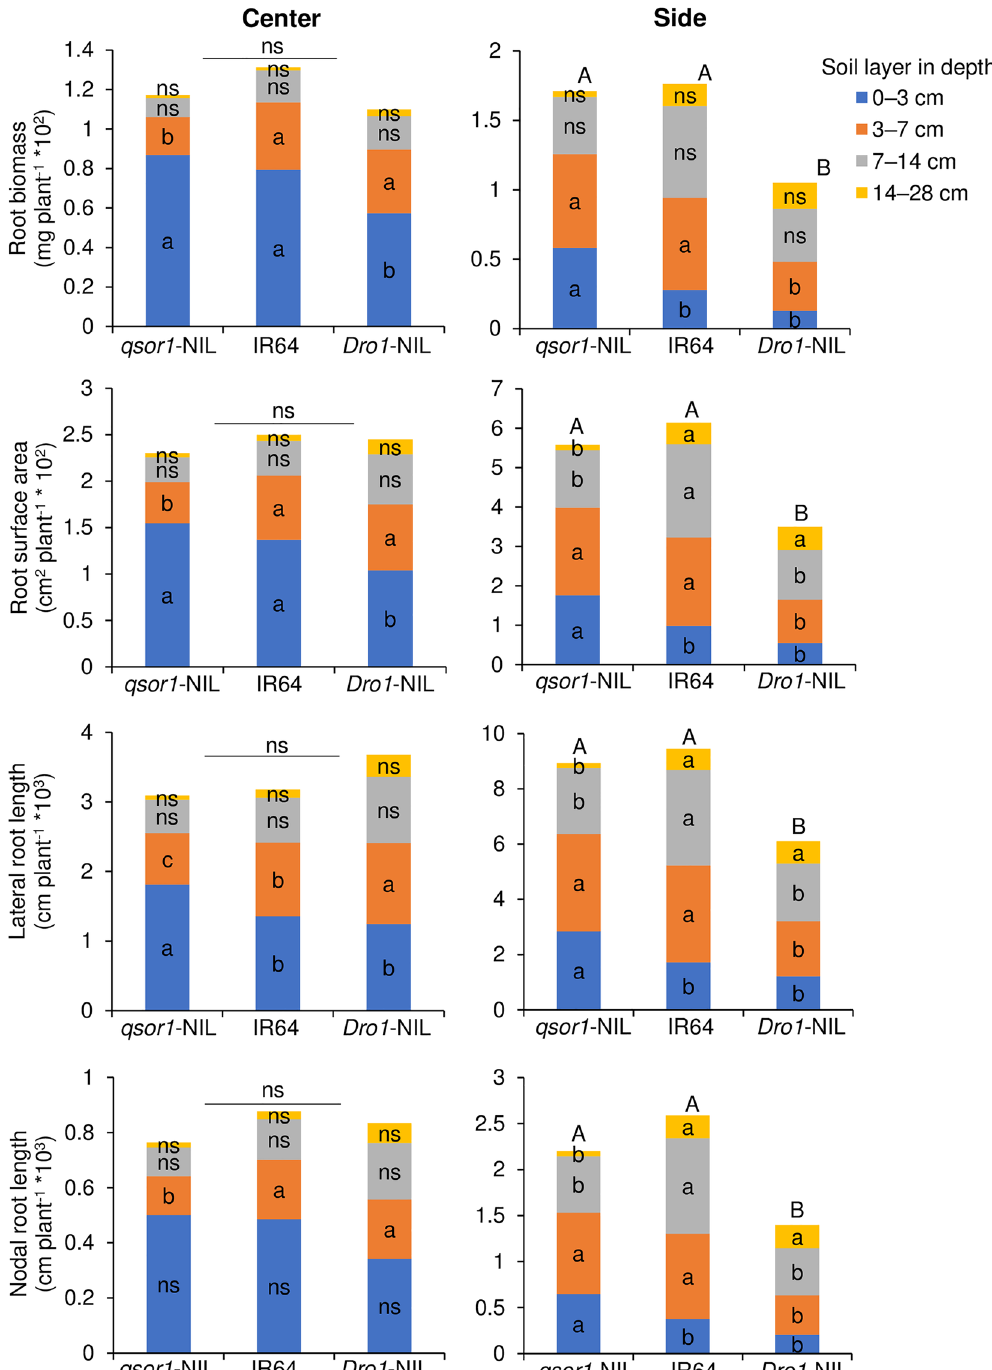
Figure 4. Horizontal and vertical root distribution patterns of three rice genotypes at 21 days after transplanting under the P-dipping (P dip ) treatment. Root parameters were shown in the center and side positions of four different soil layers (0–3 cm, 3–7 cm, 7–14 cm, and 14–28 cm). The center position indicates 3 cm from the plant base in both horizontal directions. The side position is apart from the center position. Different small letters and capital letters indicate significant differences among genotypes in these parameters within each soil layer and in total of all layers, respectively, at 5% of Turkey’s HSD test. ns not significant at 5%